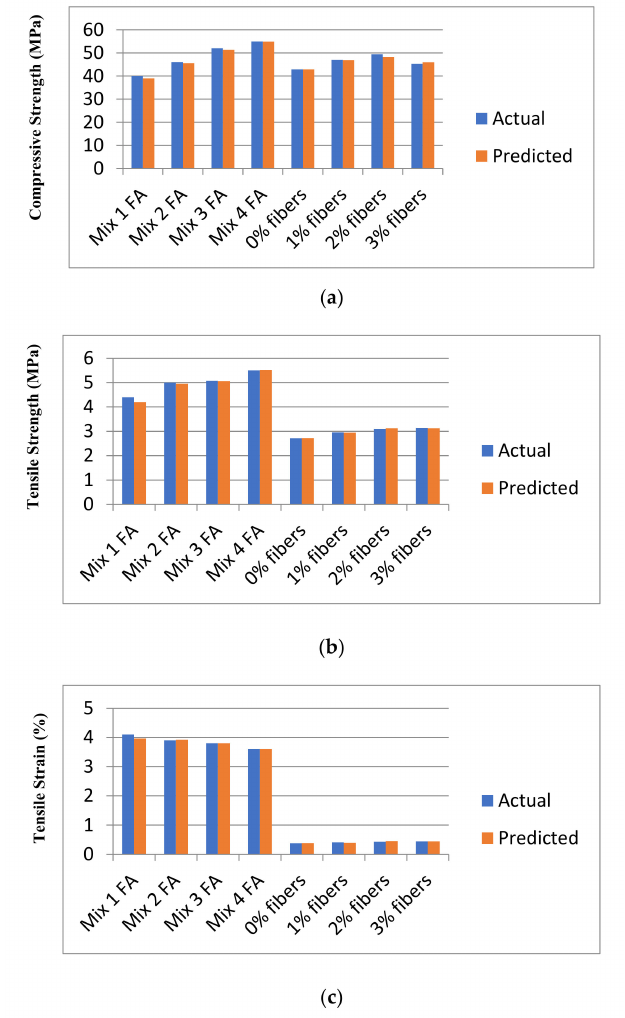
Figure 5. Comparison of prediction using XGBoost against the test results ( a ): Compressive Strength; ( b ) Tensile Strength; ( c ) Tensile